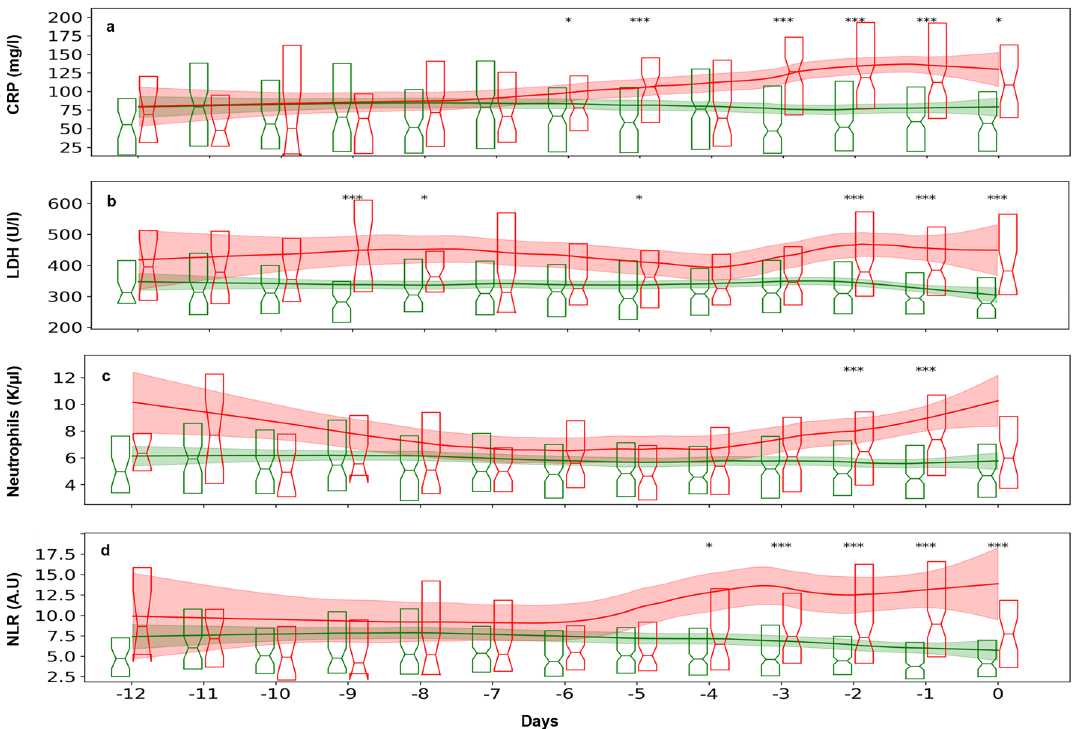
Figure 1. Longitudinal measurements of blood parameters in mild and moderate patients who would deteriorate and in those who would not deteriorate. Patients with COVID-19, collected in Sheba Medical Center, were aligned to t = 0 by the day of their first deterioration from a mild or moderate status to a severe status (red), or by the end of follow-up for patients who did not deteriorate (green). Summary boxplots, show 25th, 50th, and 75th percentiles of pooled daily ( a ) CRP values of 581 continually non-severe and 207 potentially severe patients, ( b ) LDH values of 591 non-severe and 206 severe patients, ( c ) absolute neutrophil counts of 595 non-severe and 208 severe patients, ( d ) NLR values of 595 non-severe and 208 severe patients. Locally Weighted Scatterplot Smoothing (lowess), with 95% confidence intervals are shown in continuous lines and light bands around them. Asterisks represent the level of significance of the differences between the daily status groups, determined by the p-values of the Kruskall-Wallis test, *< 0.05, **< 0.01, ***< 0.001. The test for difference was applied to the values collected at each day, separately (e.g., test whether the values between − 24 h and 0 are different, test whether the values between − 48 and − 24 h are different,